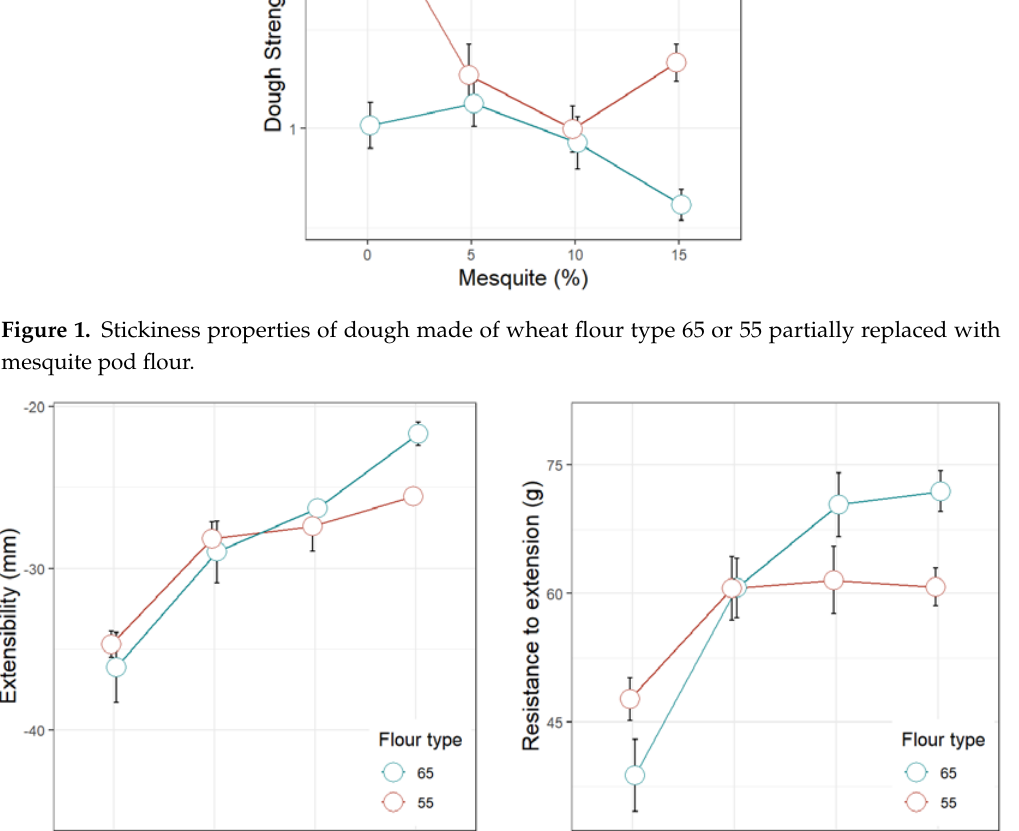
Figure 3. Loaf gravimetric properties and crumb water activity of bread made of wheat flour type 65 or 55 partially replaced with mesquite pod flour.